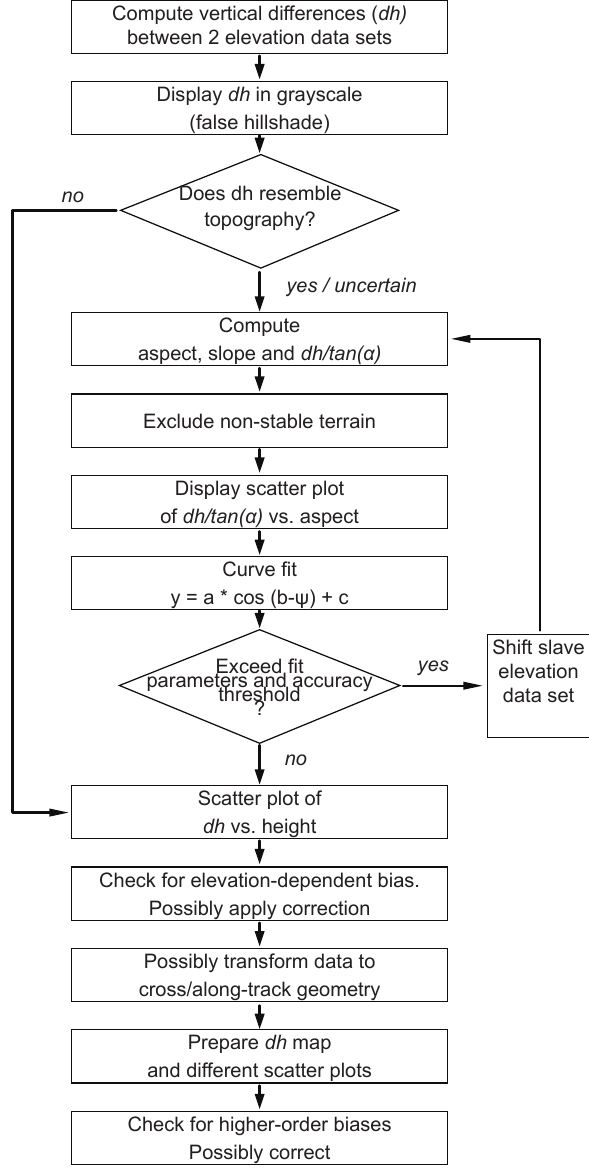
Fig. 12. A suggested methodology for comparing DEMs or eleva- tion products for glacier change